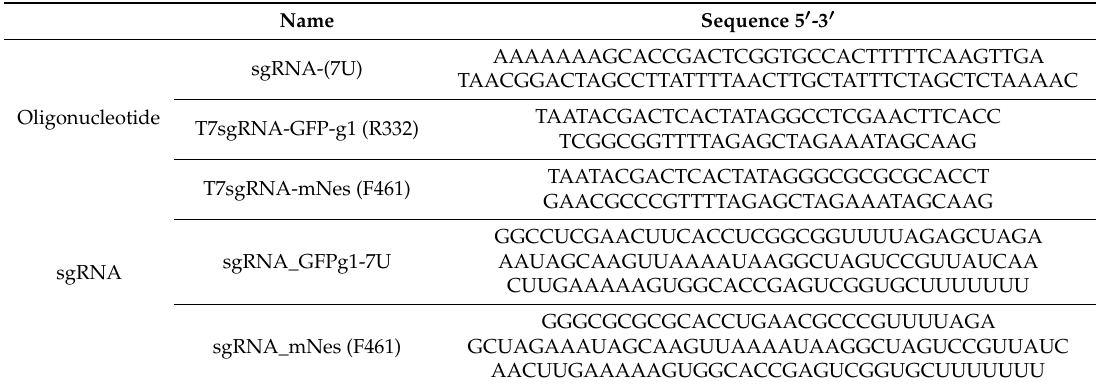
Table 1. Sequence of oligo DNA and